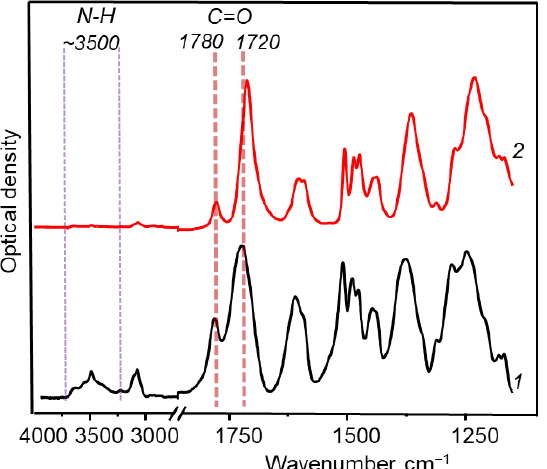
Figure 2. IR spectra of polyimides PI-ODPA before (1) thermal treatment and after (2).